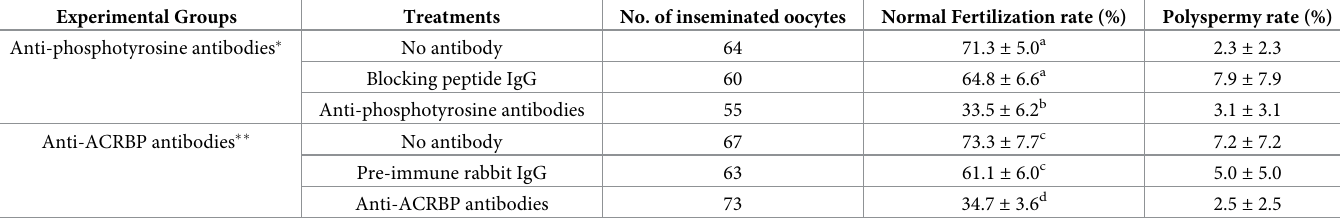
Table 2. Effect of anti-phosphotyrosine # and anti-ACRBP antibodies $ upon fertilization � . Experimental